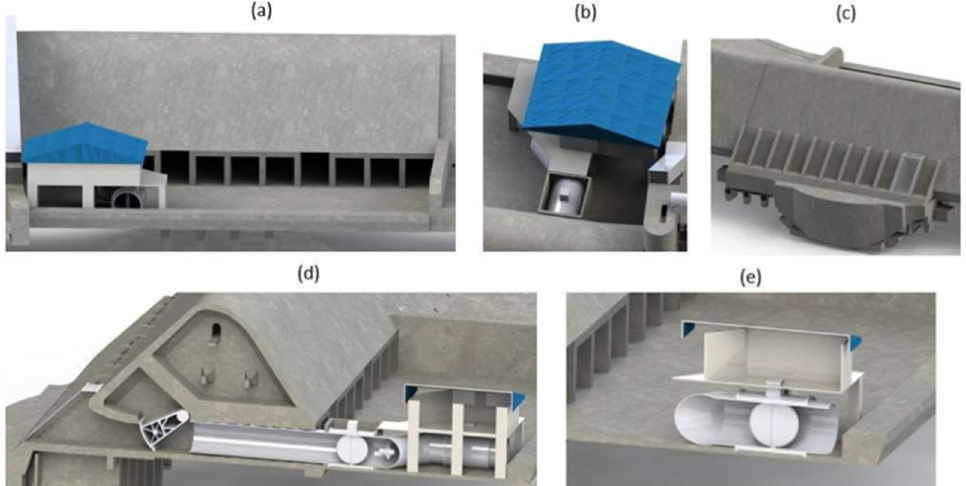
Figure 4. Detailed cross-sectional views of bottom outlet. ( a ) Downstream/front view of bottom outlet including the turbine house, penstock, etc.; ( b ) top view of bottom outlet including the turbine house, penstock, etc.; ( c ) backside of bottom outlet (foundation, trash rack, etc.); ( d ) tented gate connection to the penstock, butterfly gate no. 1, and turbine, and ( e ) penstock and butterfly gate no. 2.